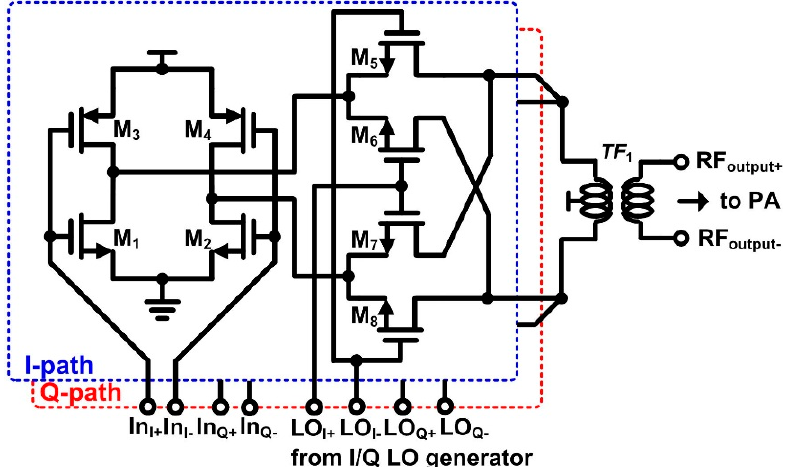
Figure 2. Simplified schematic of the proposed I / Q up-conversion mixer. (For simplicity, Q -path up-conversion mixer, direct current (DC) bias resistors, and alternating current (AC) coupling capacitors for switching transistors are omitted).